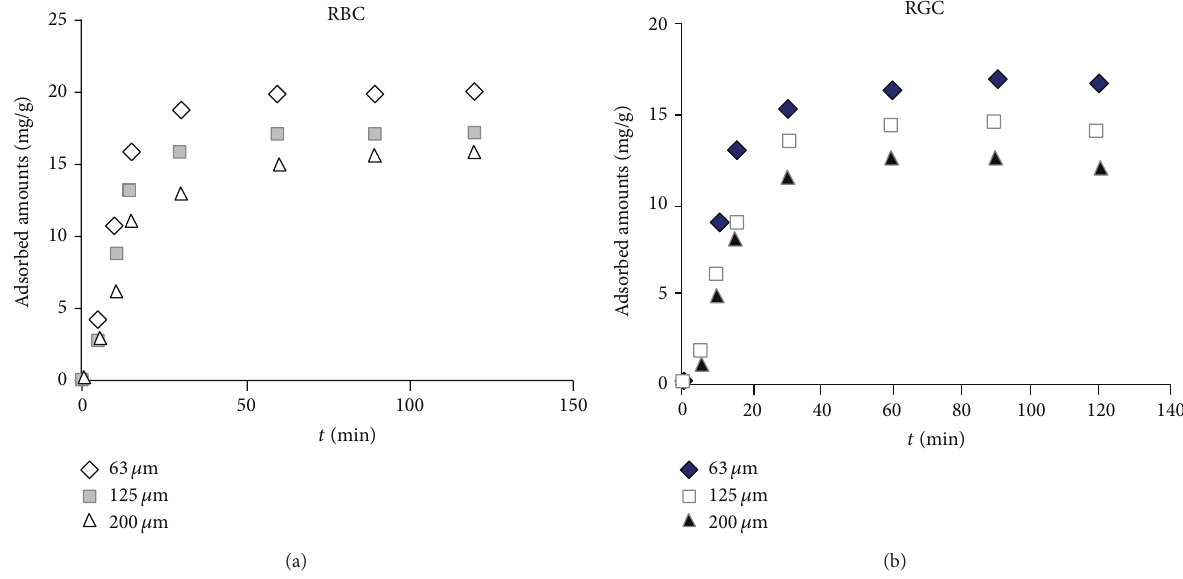
Figure 6: Effect of particle size on retention of OM using (a) RBC and (b) RGC ( 𝐶 0 = 491 ppm; PS = 63 𝜇 m; 𝑆/𝐿 = 20 g/L, 𝑇 ∘ = 35 ∘